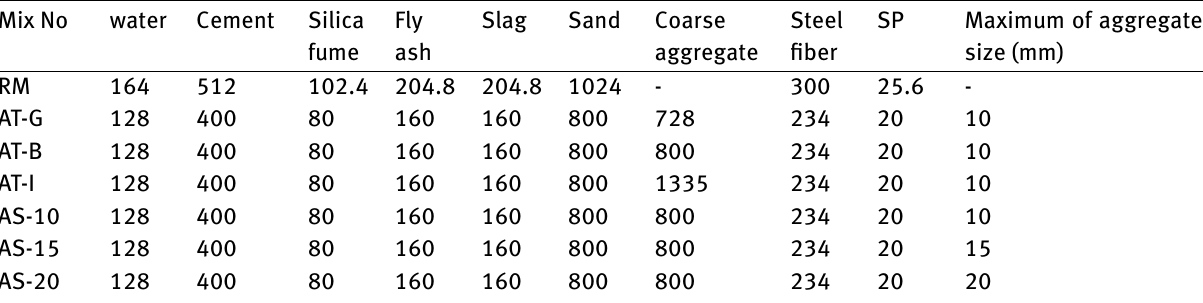
Table 3: Mixtures proportions (kg/m 3